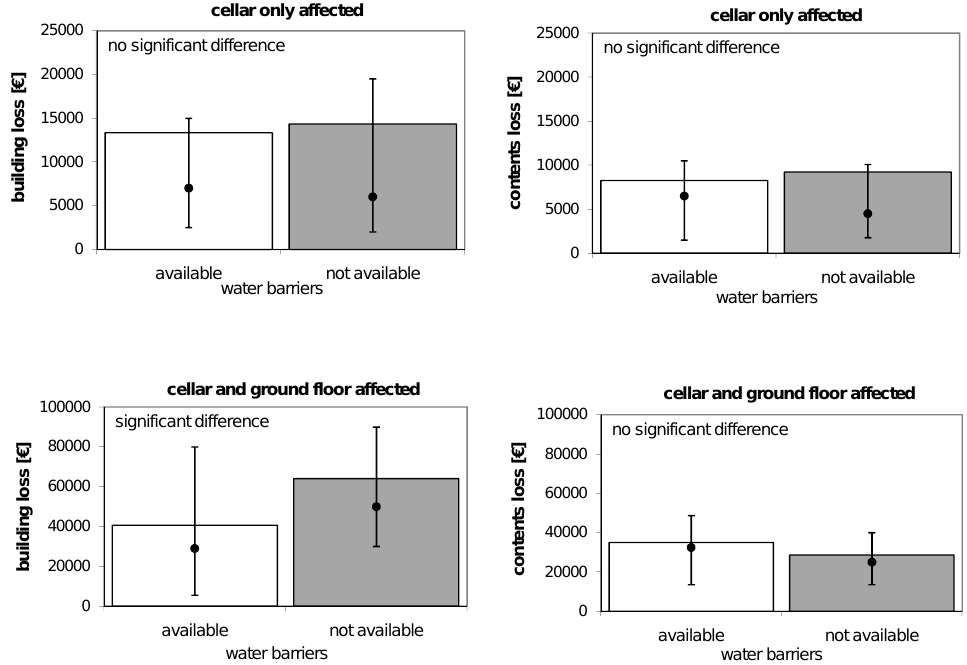
Fig. 4. The influence of water barriers on building and contents damages, separated into cases where only cellars were affected and cases where ground floors were affected as well (bars=means, points=medians and 25–75% percentiles, significant differences between the cases with/without water barriers are